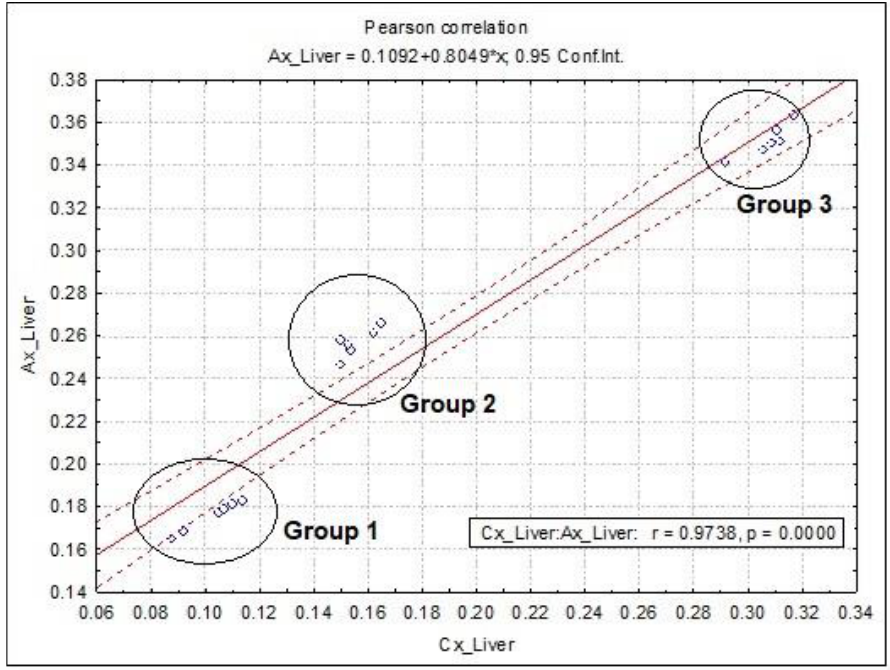
Figure 7. Pearson correlation between Ax and Cx accumulation in the liver of rainbow trout, O. mykiss .